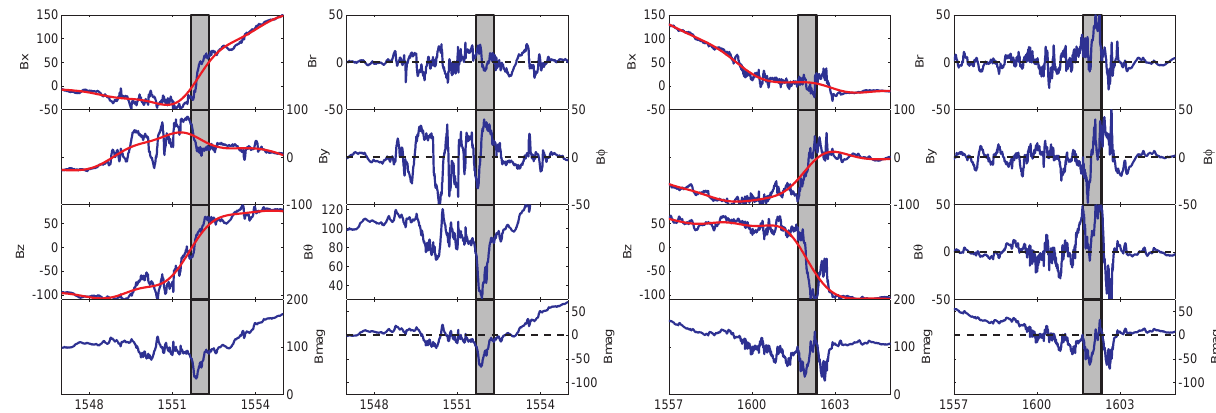
Fig. 5. Left: G8 inbound magnetopause crossing in GphiO coordinates (with the data in blue and the low-pass filtered data in red superposed) and in mean field aligned coordinates. The grey shaded area is the magnetopause crossing. Right: the same for the G8 outbound magnetopause crossing.